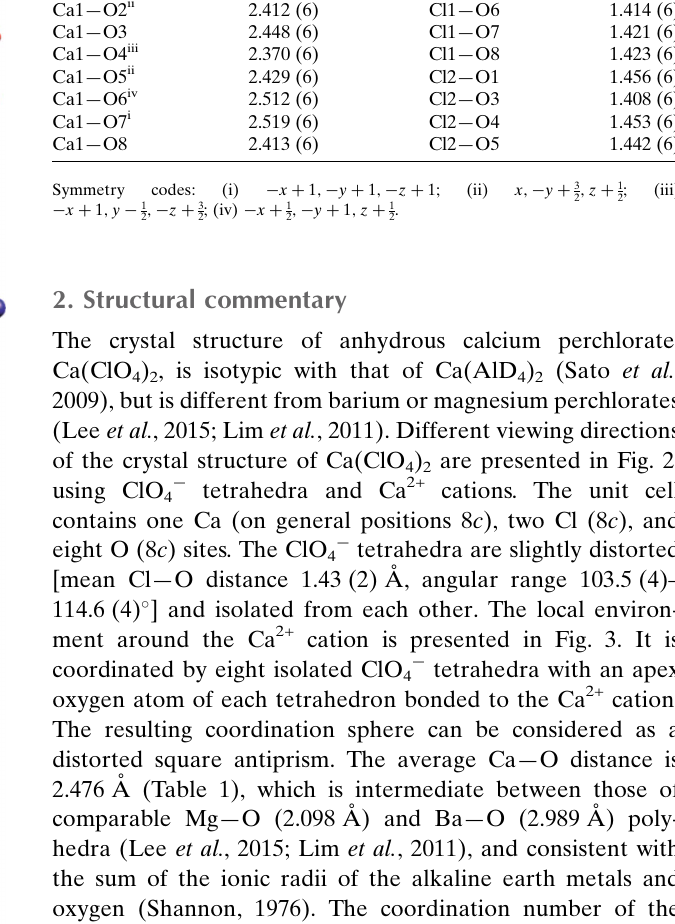
, (cid:3) z + 3 ; (iv) (cid:3) x + 1 , (cid:3) y + 1, z + 1 2 2 2 2